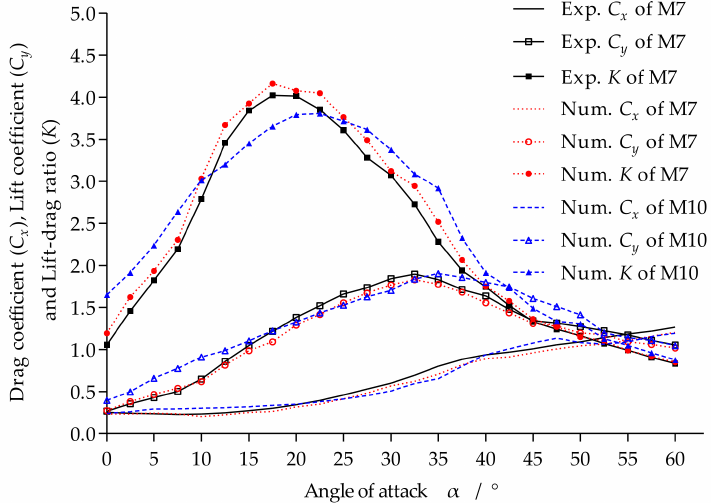
Figure 10. Comparison of the hydrodynamic performances of the otter board